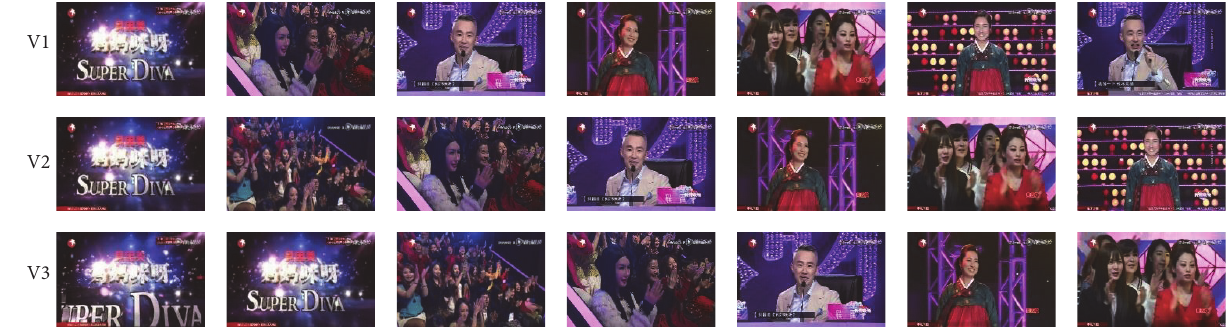
Figure 8: Three sets of key frames from different versions of the tested